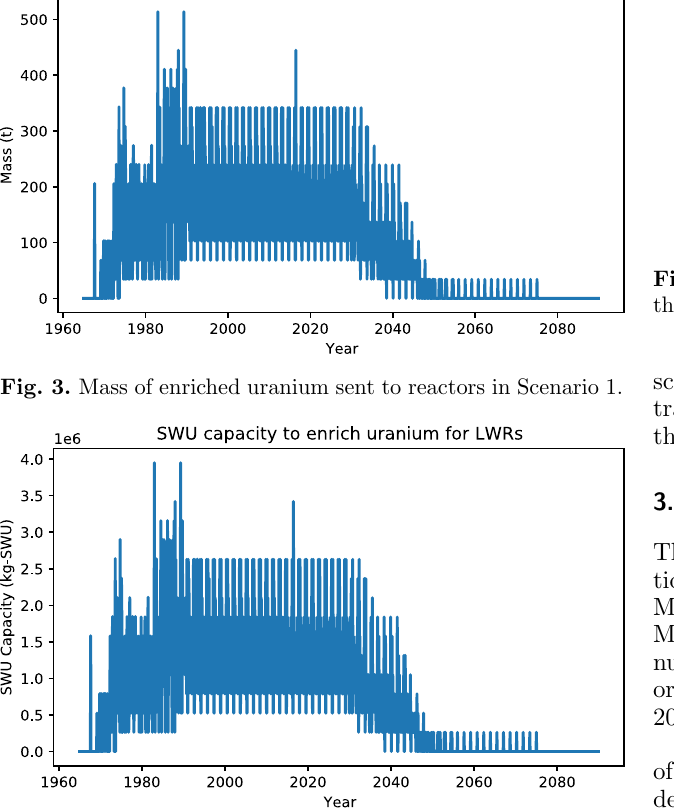
Fig. 4. Total SWU capacity required to produce fuel sent to the reactors at each time step in Scenario 1.